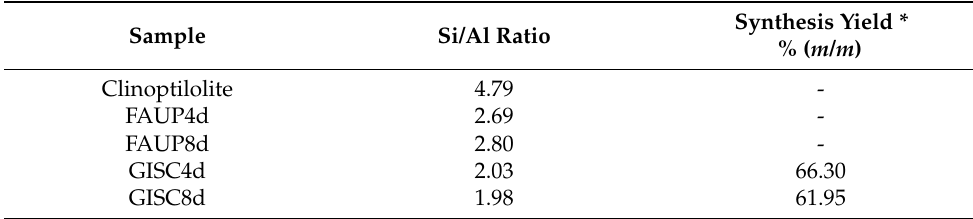
Table 1. Chemical composition (FRX) of standard FAU zeolites and GIS zeolites from clinoptilolite. Oxide